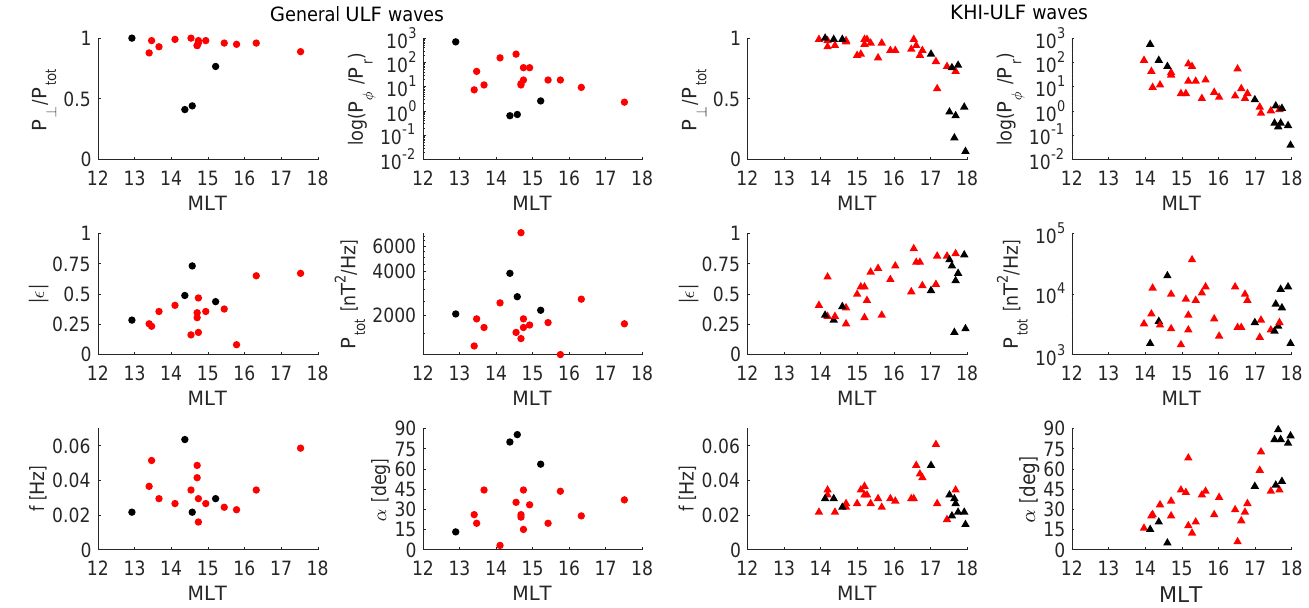
Figure 3. Comparison of the two data sets’ general ULF waves and KHI-ULF waves, in which only duskside events are included. Panels and symbols follow the same format as in Fig.